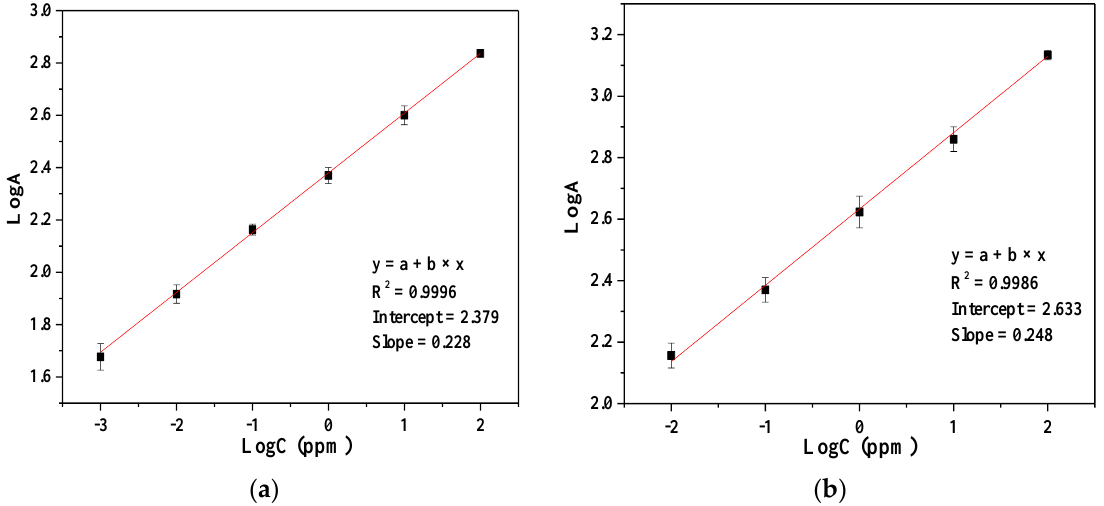
Figure 9. Relationship between the response intensity and the concentration of ( a ) H 2 S and ( b ) EDA